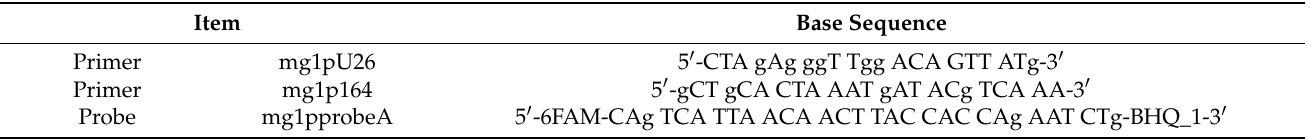
Table 1. Primers and probe used for DNA